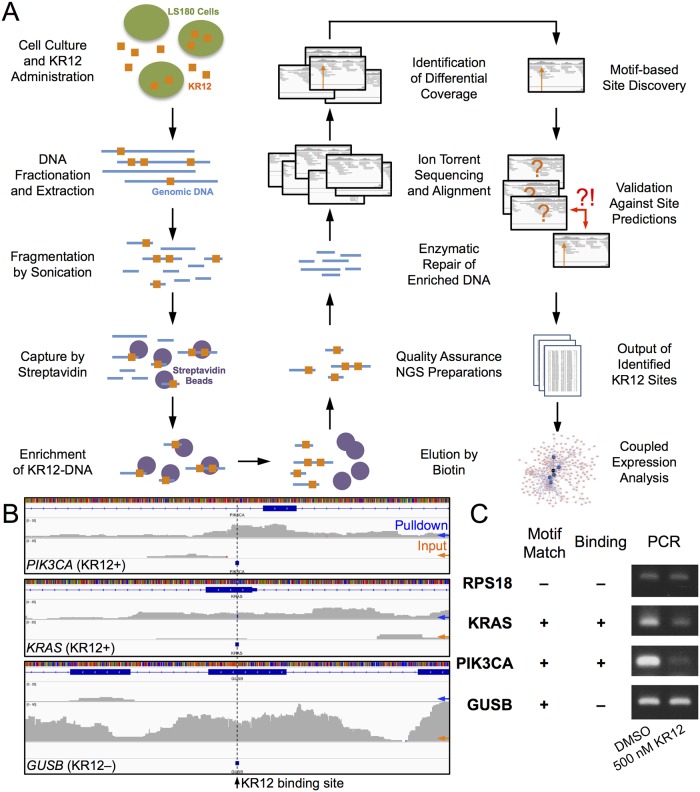
KR12 binding in the human colorectal carcinoma LS180 genome.(A) Workflow to identify KR12 binding sites in the LS180 genome by IonTorrent sequencing. Cells are administered with KR12 (500 nM, 6 h) prior to genomic DNA extraction and fragmentation by sonication. Enrichment by streptavidin allows the capture of KR12-bound nucleotides. A computational routine maps candidate regions in sequencing data, followed by site calling via motif matching and statistical validation. Subsequent microarray analyses provide the means to confirm binding data with genome-level changes. (B) Sample sequencing coverage of PIK3CA and KRAS, genes with KR12 binding sites (“KR12+”), and for reference, a predicted site by motif matching but non-binding (“KR12–”) in GUSB; windows centered around a KR12 site (black arrow, dashed line) are within –500 to +500 bp; blue and orange arrows indicate cumulative coverage for the pulldown and input tracks, respectively. (C) Semi-quantitative PCR of RPS18, KRAS, PIK3CA and GUSB in the presence of 500 nM KR12 or DMSO as control. “Motif match” and “binding” indicate whether a particular gene contains a computationally predetermined match to the KR12 motif in the hg19 genome or a KR12 binding site determined by sequencing analysis, respectively.